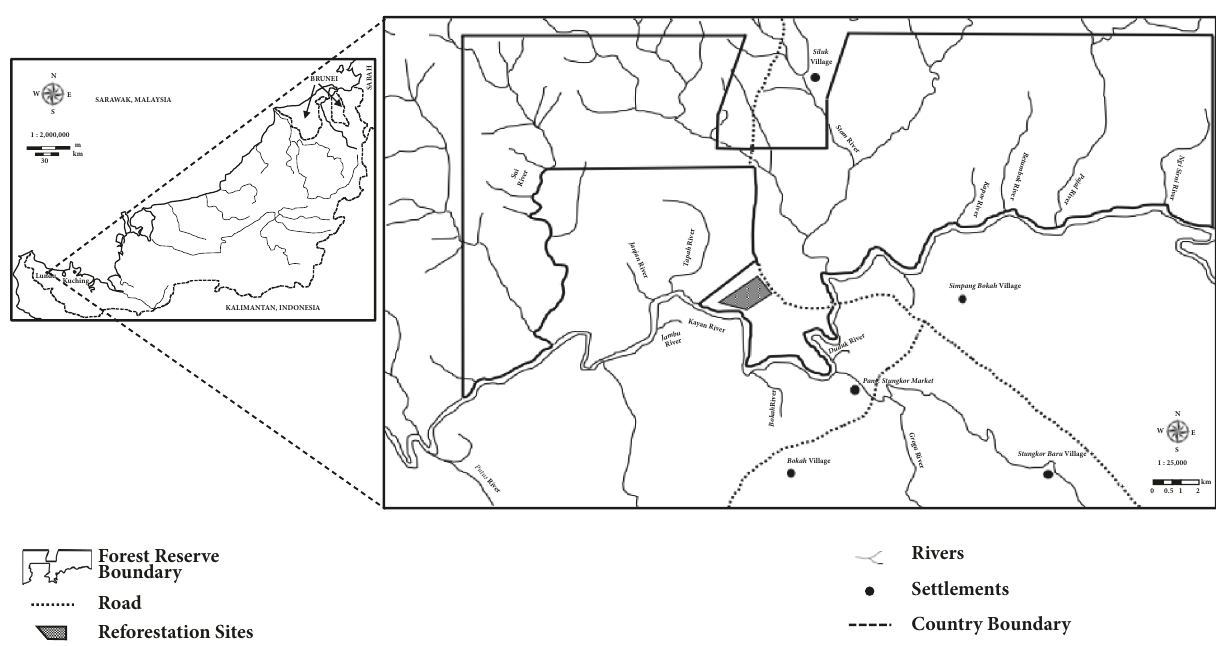
Figure 1: Location of the study area: Sampadi Forest Reserve, Lundu, Sarawak. Perumal et al.; Department of Agriculture, Sarawak, Malaysia [11,